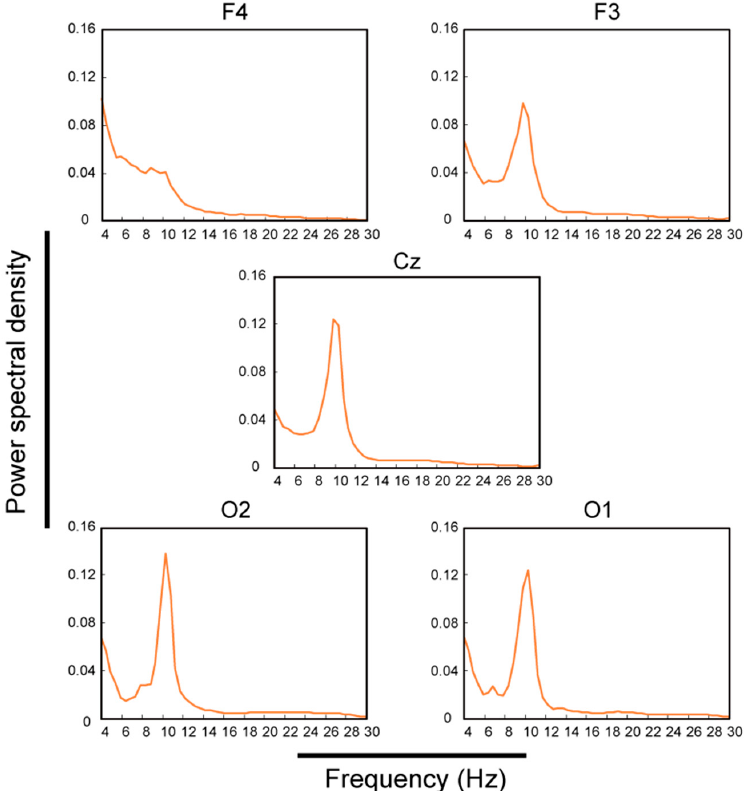
Figure 11. Power spectral density ( PSD ) for each channel averaged over all subjects for channels F3, F4, Cz, O2, and O1. The alpha band spanned from 8 to 13 Hz.